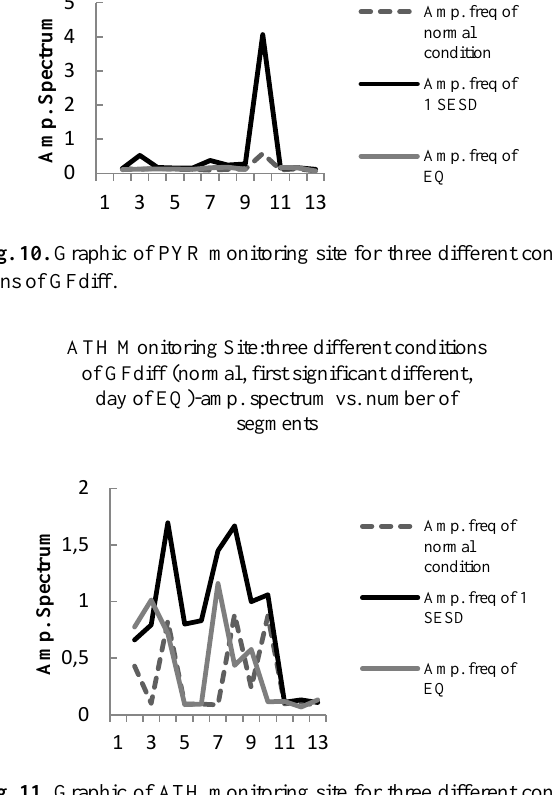
Fig.12. Graphic of HIO Monitoring site three different conditions of GFdiff.